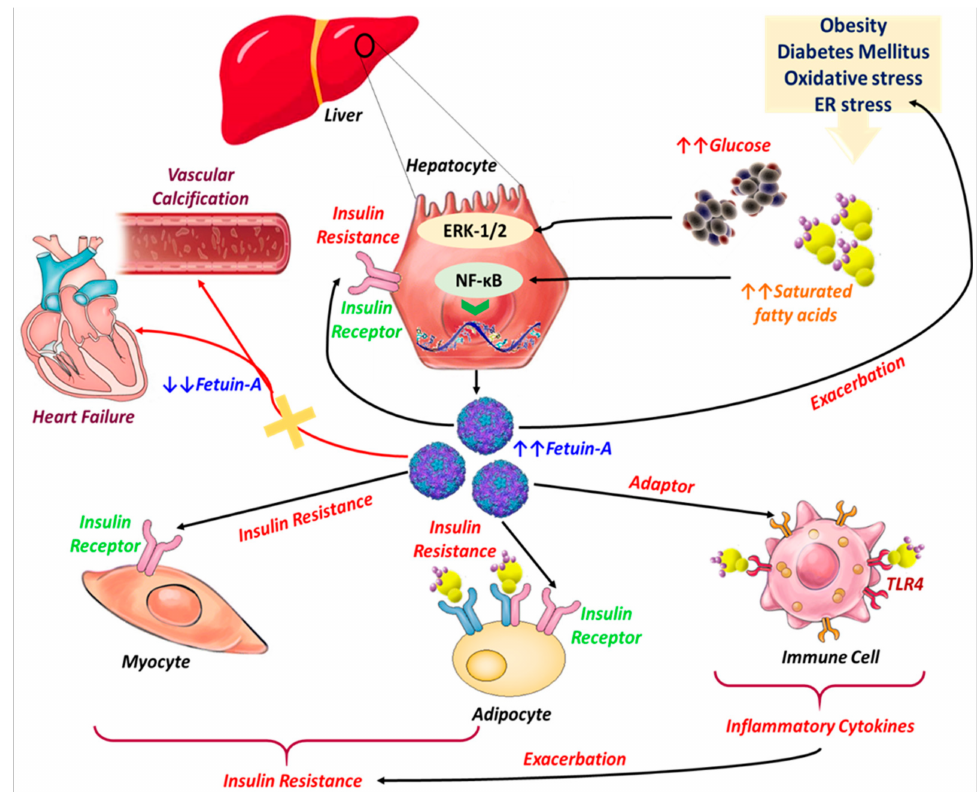
Figure2. PathophysiologicalimplicationsofFet-Ainthecourseofmetabolicandcardiovasculardiseases. Excessive release of Free fatty acids (FFAs) and overaccumulation of glucose in the bloodstream stimulate the biosynthesis of Fetuin-A from hepatocytes through activation of both Nuclear factor kappa B (NF- κ B) and ERK 1 / 2 pathways. Fet-A acts then as an insulin signaling pathway inhibitor by modulating the kinase reaction initiated by insulin on insulin-receptor tyrosine kinase autophosphorylation; insulin-sensitive tissues become less responsive to insulin, triggering insulin resistance. Meanwhile, Fet-A functions as an adaptor between FFA and Toll like receptor 4 (TLR4) signaling in lipid-induced inflammation, and TLR4 signaling leads to the activation of NF- κ B and Activator protein 1 (AP-1), which can then upregulate the transcription of inflammatory genes, resulting in the production of inflammatory cytokines that can lead to insulin resistance. On the other hand, decreased Fet-A synthesis is strongly correlated with excessive vascular calcification and general heart failure, as the Fet-A-stabilization e ff ect toward insoluble calcium and phosphate crystals is no longer properly